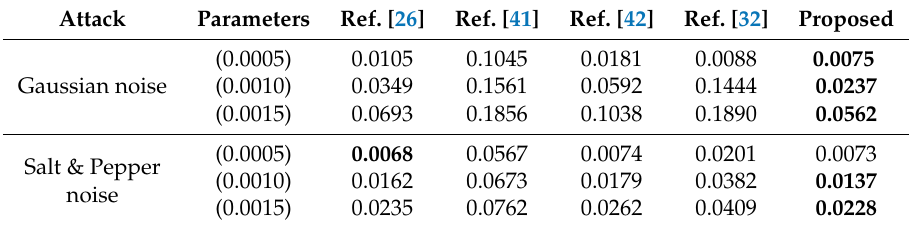
Table 2. The average BER comparison with PSNR = 42 dB under noise attacks.